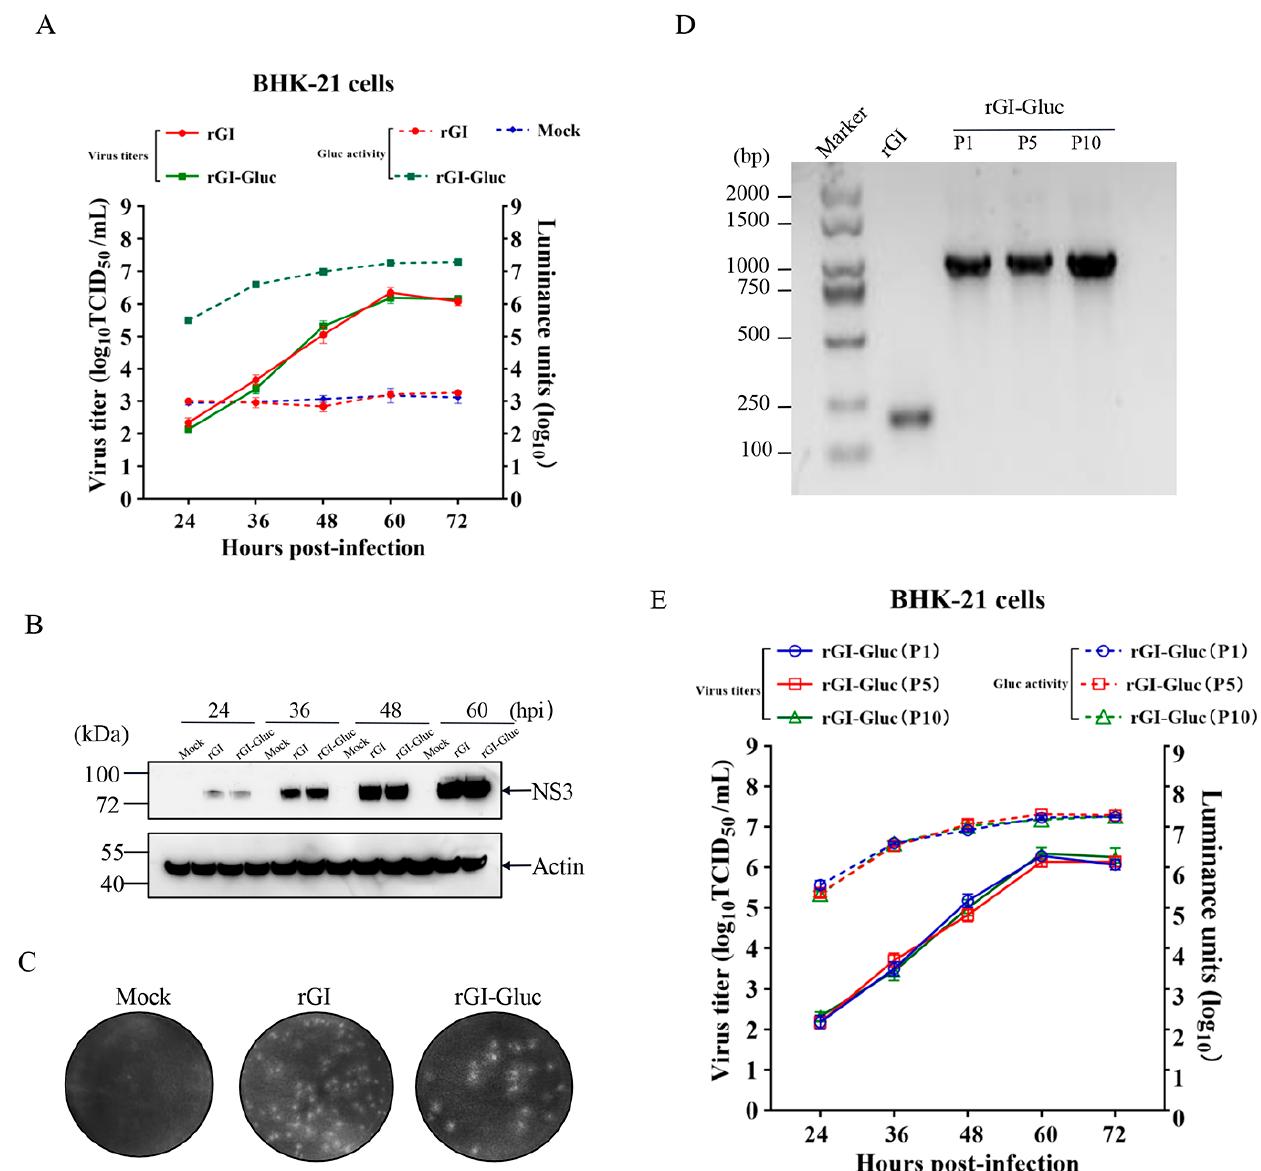
Figure 2. Characterization and genetic stability of Gluc-tagged GI JEV. ( A ) The multi-step growth curves of the parental virus and the reporter virus. The BHK-21 cell monolayers were respectively infected with rGI-Gluc or rGI at an MOI of 0.01. The supernatants were harvested to titrate by TCID50 assays in BHK-21 cells or subject to luciferase assay at indicated time points after infection. All data are presented as mean ± SD from three independent experiments. ( B ) The expression of NS3 protein in infected BHK-21 was determined by western blot analysis. The cell lysates at the indicated time points were harvested and subject to western analysis with an anti-NS3 antibody. β -actin was detected as a loading control. NS3 and β -actin were indicated by black arrows. ( C ) The plaque mor- phology formed by rGI-Gluc and rGI in BHK-21 cells. The BHK-21 cells were respectively infected with rGI or rGI-Gluc at a dose of 200 TCID50. At 4 dpi, the cells were fixed with 4% paraformalde- hyde and the plaques were visualized by crystal violet staining. ( D ) RT-PCR amplification of viral genomic region covering the Gluc expression cassette in rGI-Gluc. The corresponding genomic re- gion in rGI was also amplified using the same pair of primers. The expected sizes of amplicons are 1.1 kb and 0.22 kb for rGI-Gluc and rGI. ( E ) The multi-step virus growth curves of rGI-Gluc of P1, P5, and P10 are based on viral progenies and Gluc activities in culture supernatants.